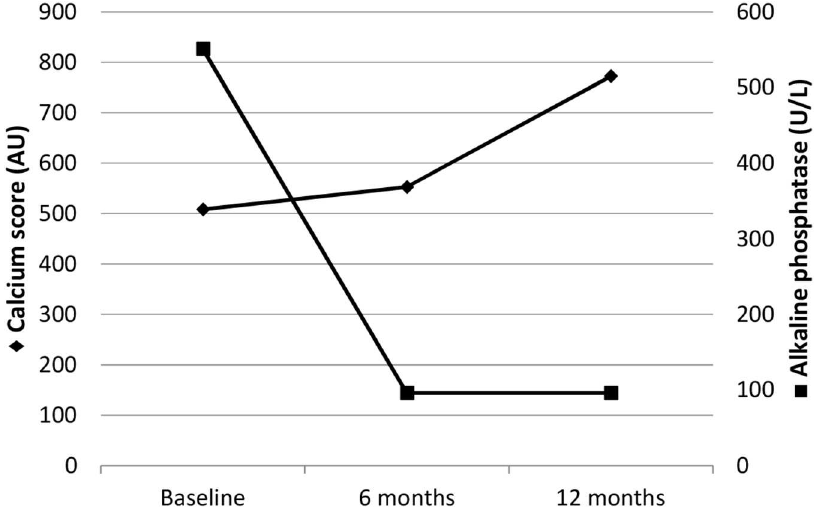
Fig 2. Calcium score and alkaline phosphatase in hemodialysis patients with VC during 12 months after parathyroidectomy (n = 14).